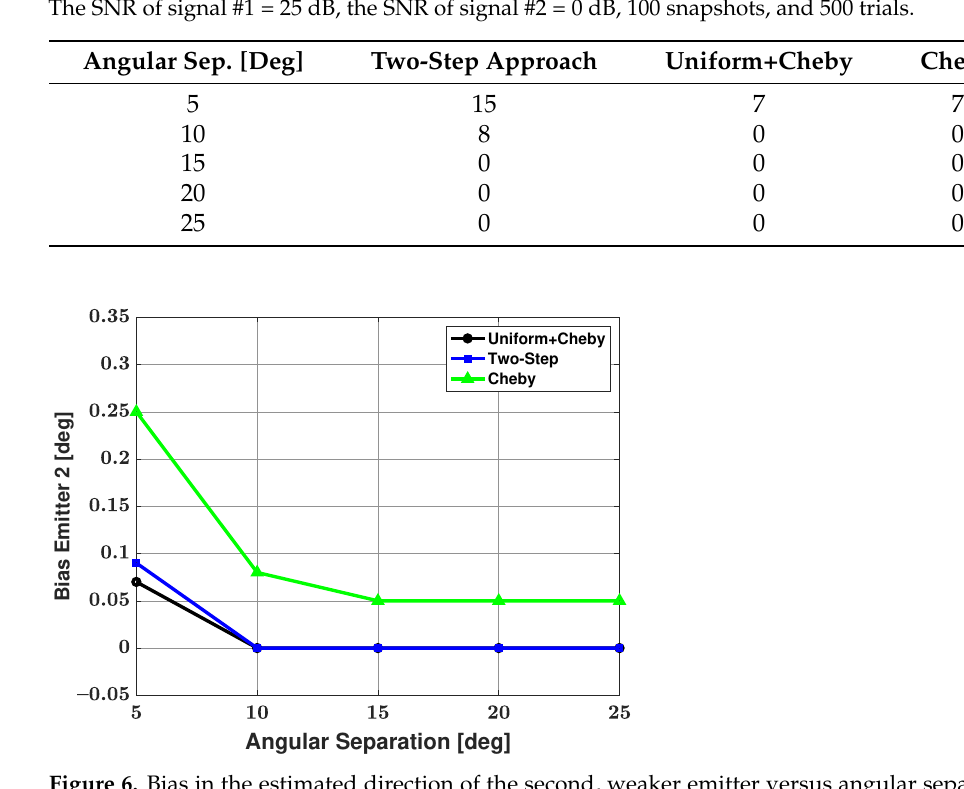
Table 1. Number of failures in 500 trials with respect to angular separation for a two-signal scenario.